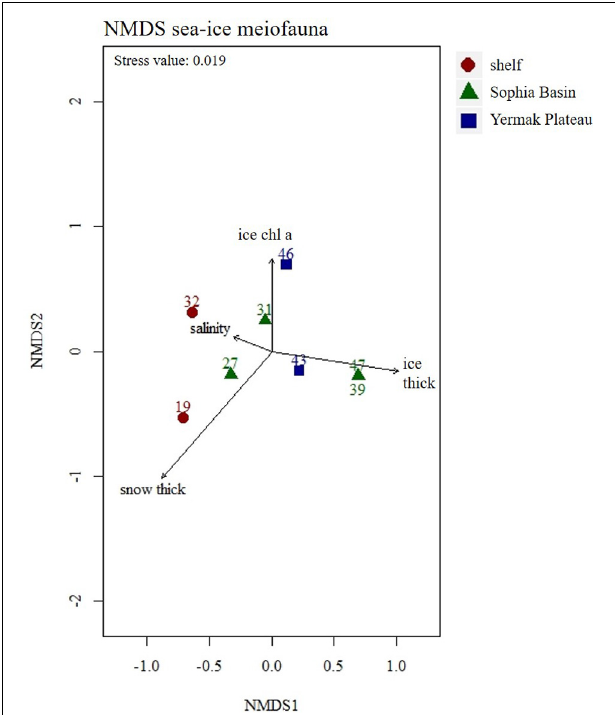
FIGURE 5 | Non-metric Multidimensional Scaling (NMDS) plot of sea-ice meiofauna abundances with four fitted environmental variables. Stations were color coded according to geographical regions (shelf, Sophia Basin, and Yermak Plateau). Ice thick, ice thickness; ice chl a , ice chlorophyll a ; snow thick, snow